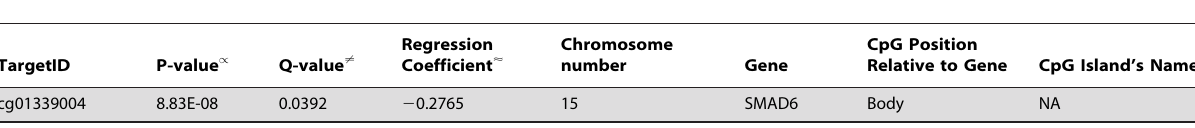
Table 4. Significant CpG sites in a linear regression model.